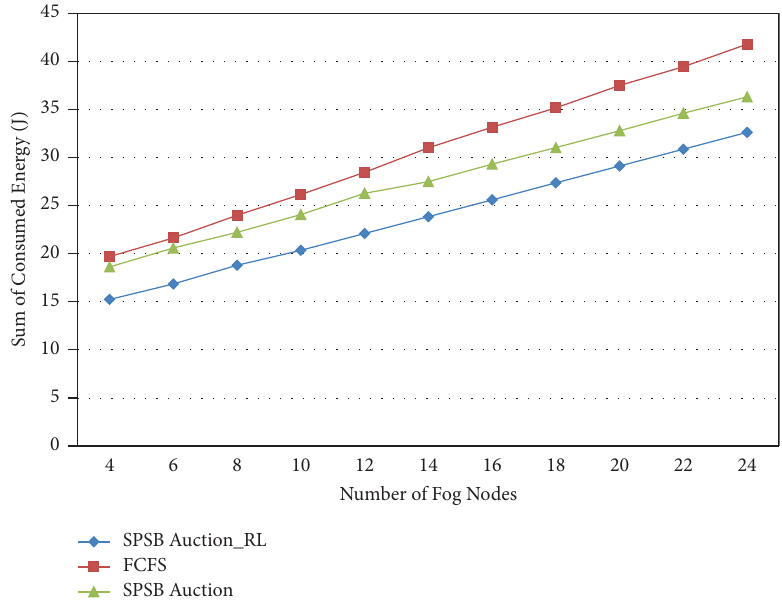
Figure 7: Energy consumption for diferent numbers of fog nodes.